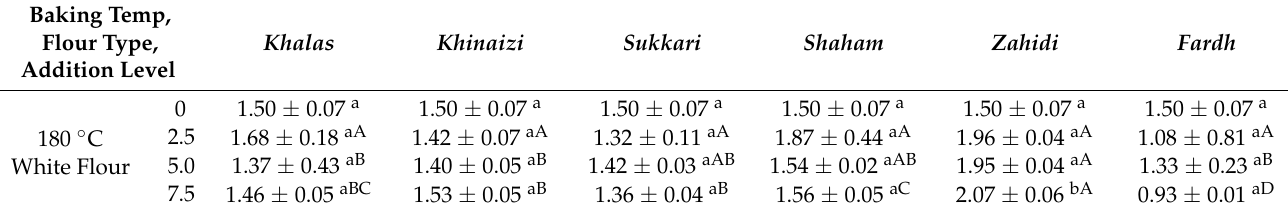
Table 3. Ash content of cookies 1